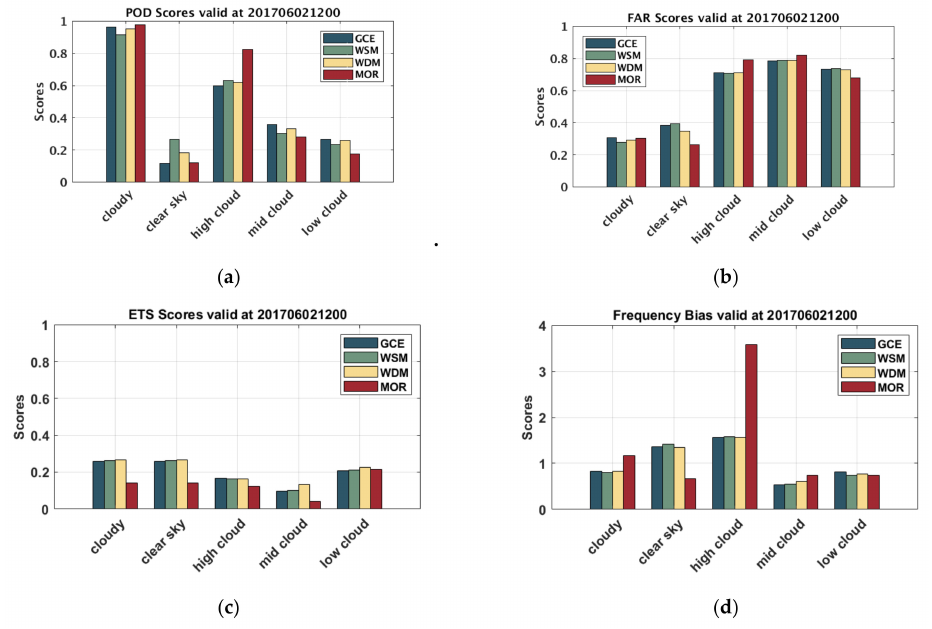
Figure 10. Skill score of each cloud type. Valid on June 2 at 1200 UTC. ( a ) POD, ( b ) FAR, ( c ) ETS, and ( d )